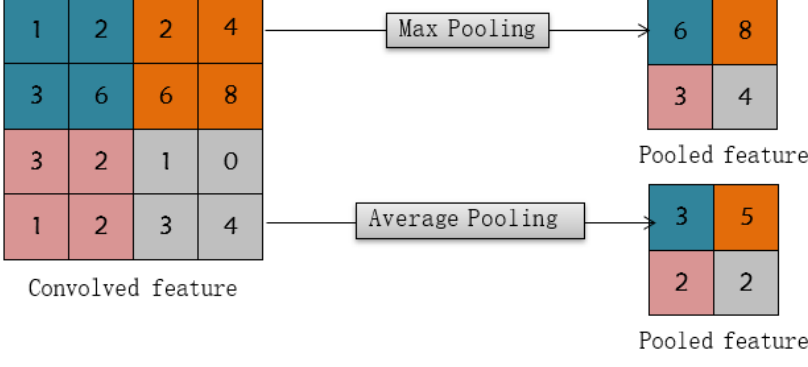
Figure 4. Pooling